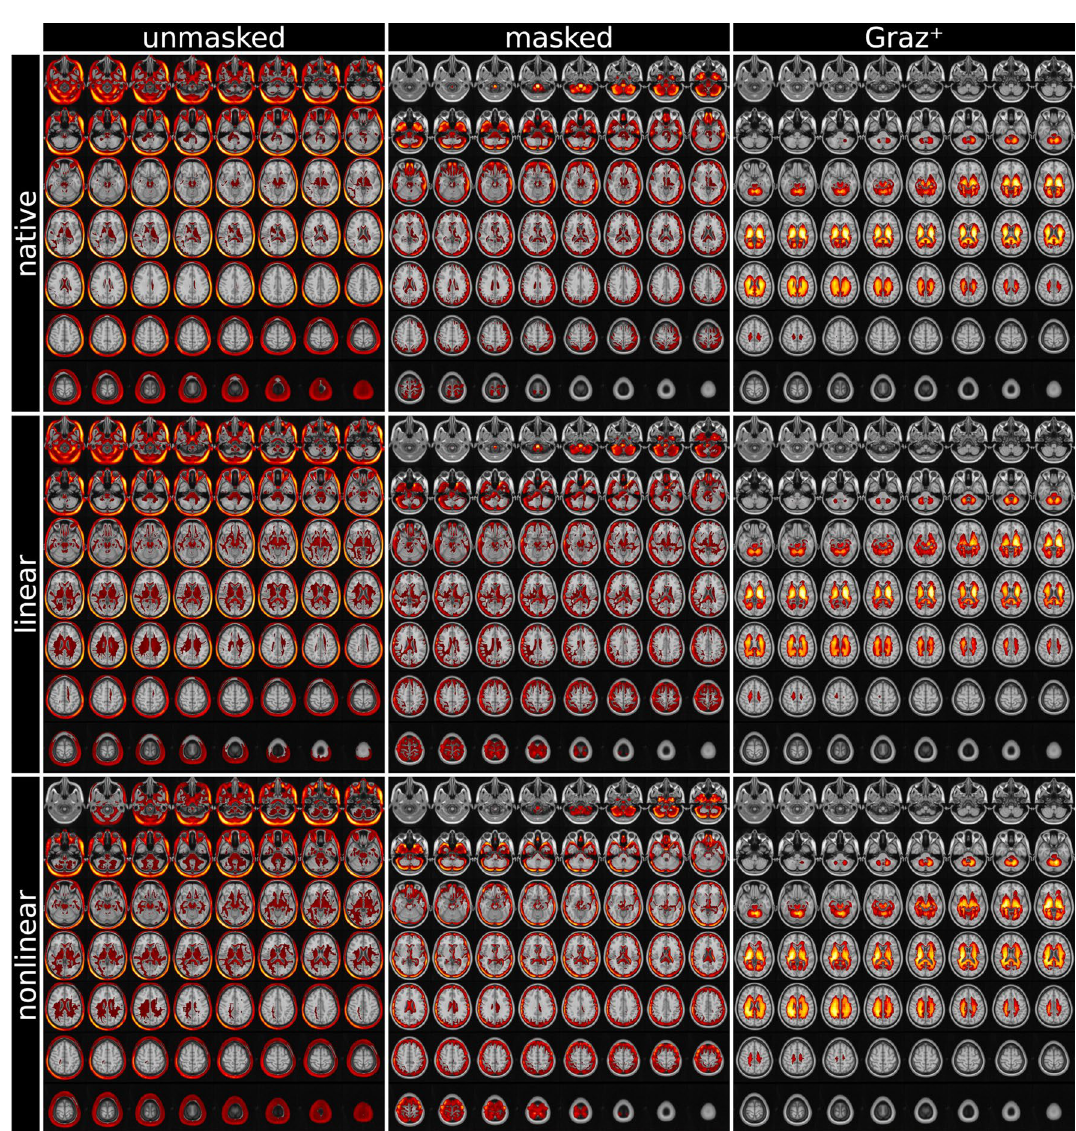
tricular location, partly overlapping with the regions identified here by the Graz + -based models 61 . Furthermore,